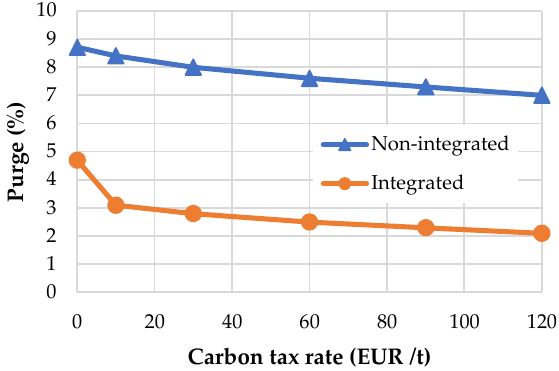
Figure 3. Fraction of purge stream at different values of the CO 2 tax rate. The total conversion of reactant A increases with the CO 2 emission tax, as shown in Figure 4. The conversion in the process with heat integration is 13% higher than in the process without heat integration.